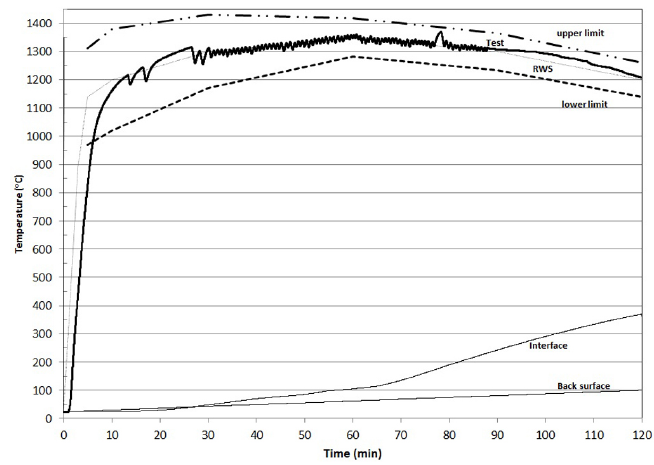
Figure 2. Performance of K-geopolymer at the second RWS fire load curve.